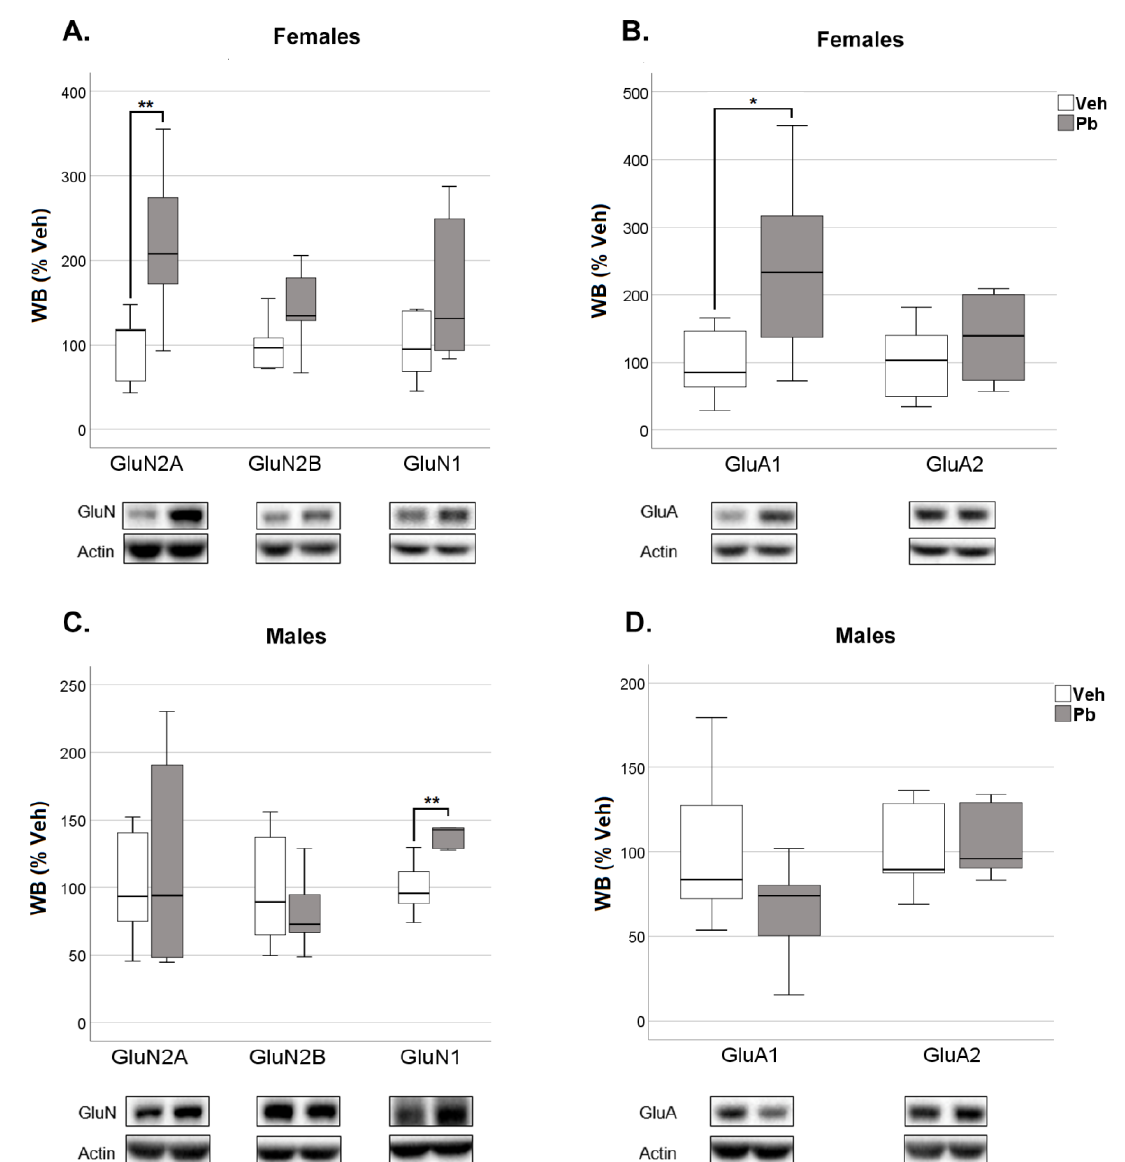
Figure 8. Effect of Developmental Pb Exposure on the Expression of NMDA and AMPA Receptor Subunits in the Triton-Insoluble Fraction (TIF) of 23 Post-Natal Day Female and Male Rat Hippocampi. Quantification and representative Western blots of glutamatergic receptor subunits in females ( A , B ) and males ( C , D ) in Veh and Pb rats. Data were normalized on actin levels and are represented as % of Veh ( n = 5–8); * p < 0.05, ** p < 0.01.